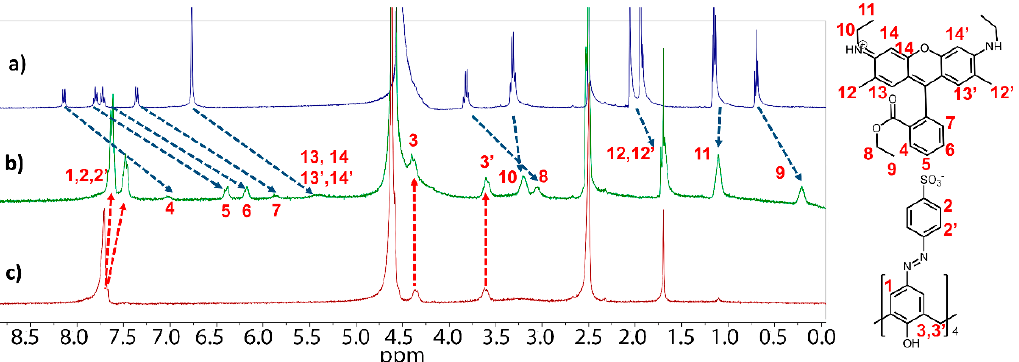
Figure 4. 1 H NMR spectra of 0.5 mM Rh6G ( a ), 1 mM calixarene 1 ( c ) and their (0.5:1) mixture ( b ) in DMSO-d6:D 2 O (2:3) at 25 °C, 10 mM PBS buffer (pD 7.4).